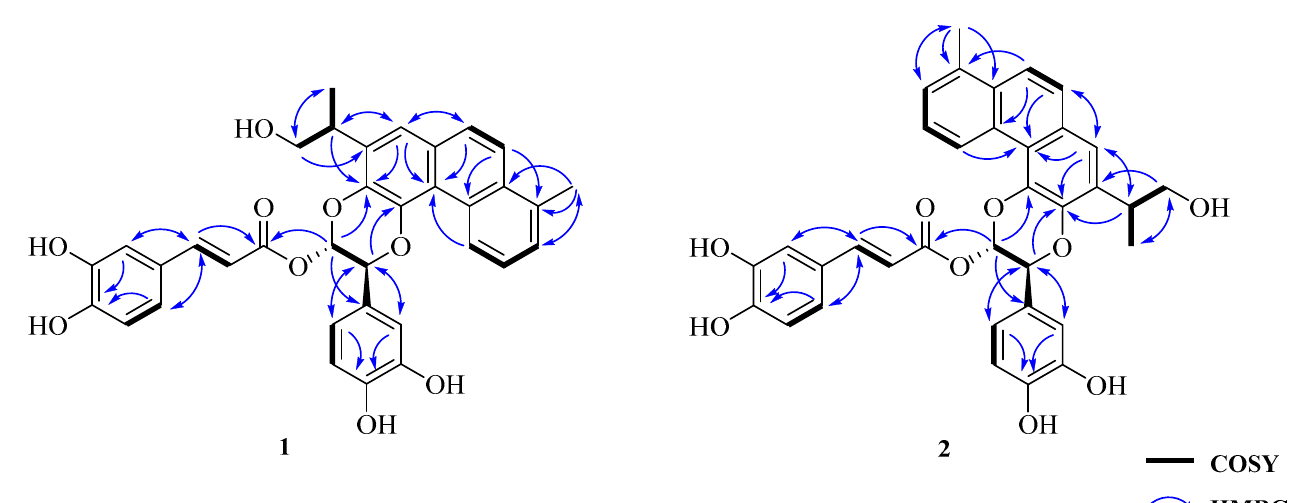
Figure 2. Key COSY and key HMBC correlations of compounds 1 and 2 .